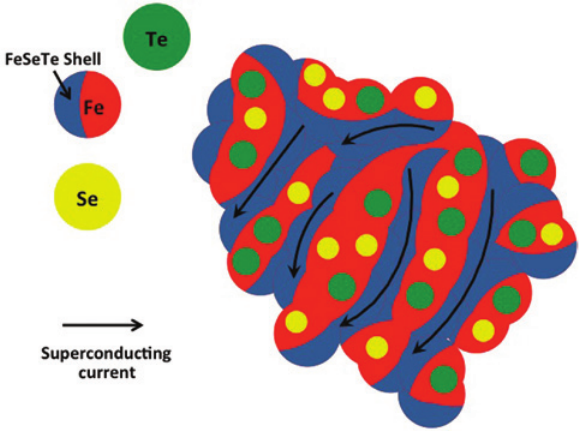
Te sample formed through 0.5 0.5